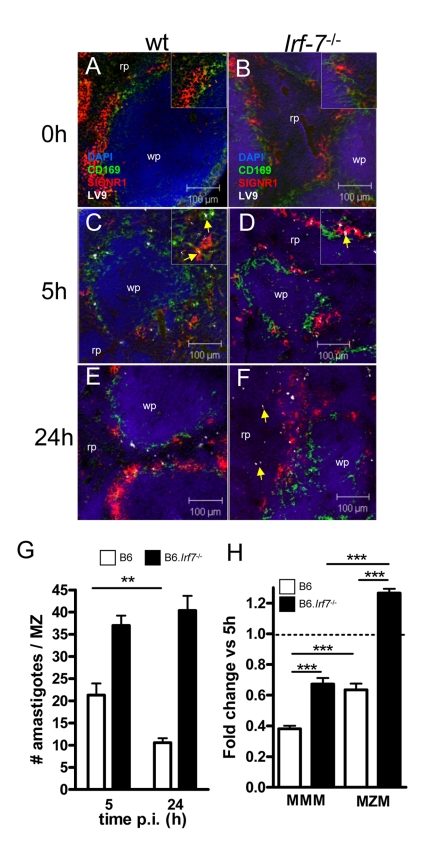

Irf-7−/− MZM and MMM are defective in anti-leishmanial activity.(A–F) Parasite localisation in wild type and Irf-7−/− mice. Spleens from naïve C57BL/6 (A) and Irf-7−/− (B) mice and C57BL/6 (C, E) and Irf-7−/− (D, F) mice infected with L. donovani for 5h or 24h, were stained for CD169 (green), SIGNR1 (red), Leishmania (white) and counterstained with DAPI (blue). Higher magnification inserts show localization of amastigotes (arrowed). (G) Parasite load in the MZ of C57BL/6 mice (open bars) and B6.Irf-7
−/− mice (black bars) was determined by counting the number of parasites per MZ area *, p<0.05, **, p<0.01. (H) The number of amastigotes in CD169+ MMM and SIGNR1+ MZM of B6 (open bars) and Irf-7−/− (black bars) mice was determined at 5h and 24h (n = 64 MZ profiles, from 4 mice per time point per strain). Data are presented as fold change at 24h. ***, p<0.001. Scale bars; 100µm.